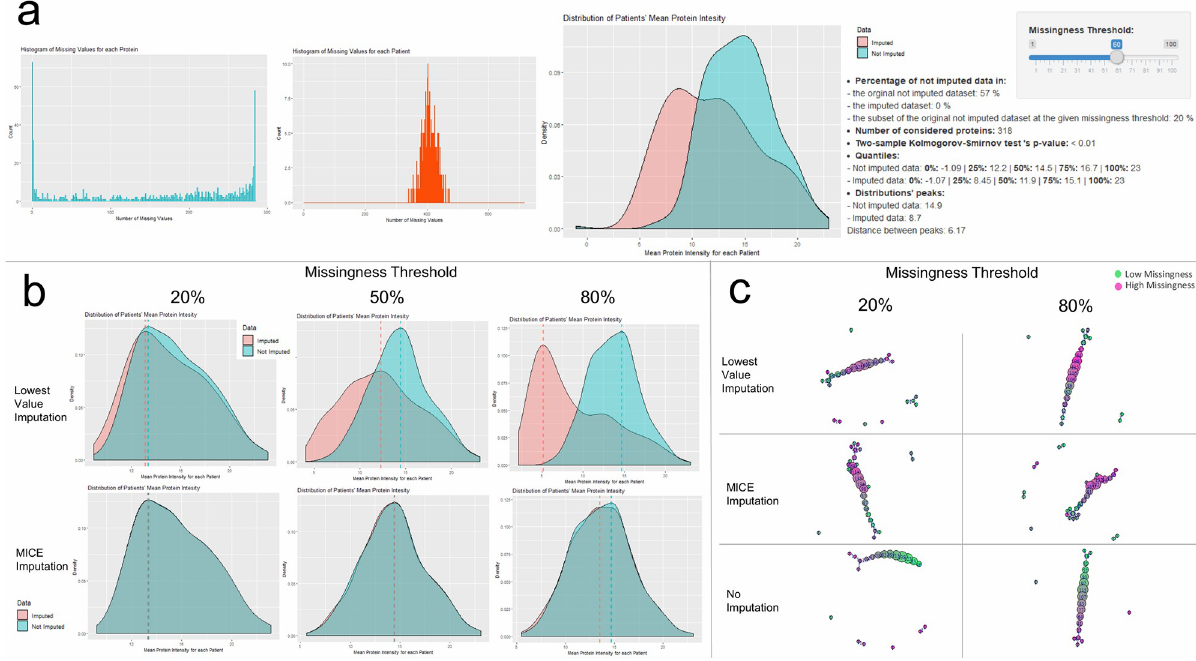
Fig 3. OptiMissP results in the Salford Kidney Study proteomic dataset. A) This panel presents the missingness histograms of patients’ and proteins and the density plot of patients’ mean protein intensity based on all the data with details on missingness in the text sections. B) This figure shows the density plots of patients’ mean protein intensity of imputed and not imputed data comparatively for Lowest Value (MNAR) an MICE (MAR) imputation methods and three different missingness thresholds (20%,50% and 80%). C) The section displays the results of TDA applied on not imputed data, MNAR imputed data and MAR imputed data considering two missingness thresholds. The lenses, the distance matrix and the resolution parameters are fixed. The lenses are L1 Infinity Centrality and PPCA First Component, the distance metric is the Euclidean form, the percentage of overlap is 50%, the Single Linkage Clustering’s parameter is set at 10 and the intervals are respectively 16 and 15 for the first and the second lens.